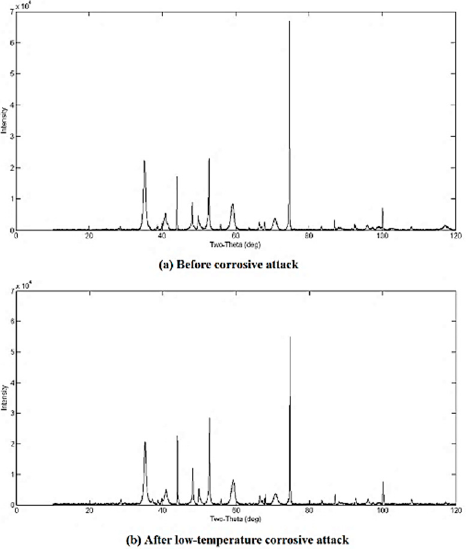
Figure A27. Qualitative XRD analysis of the surface of CS-B-Z ( a ) before corrosive attack, ( b ) after low-temperature corrosive attack.